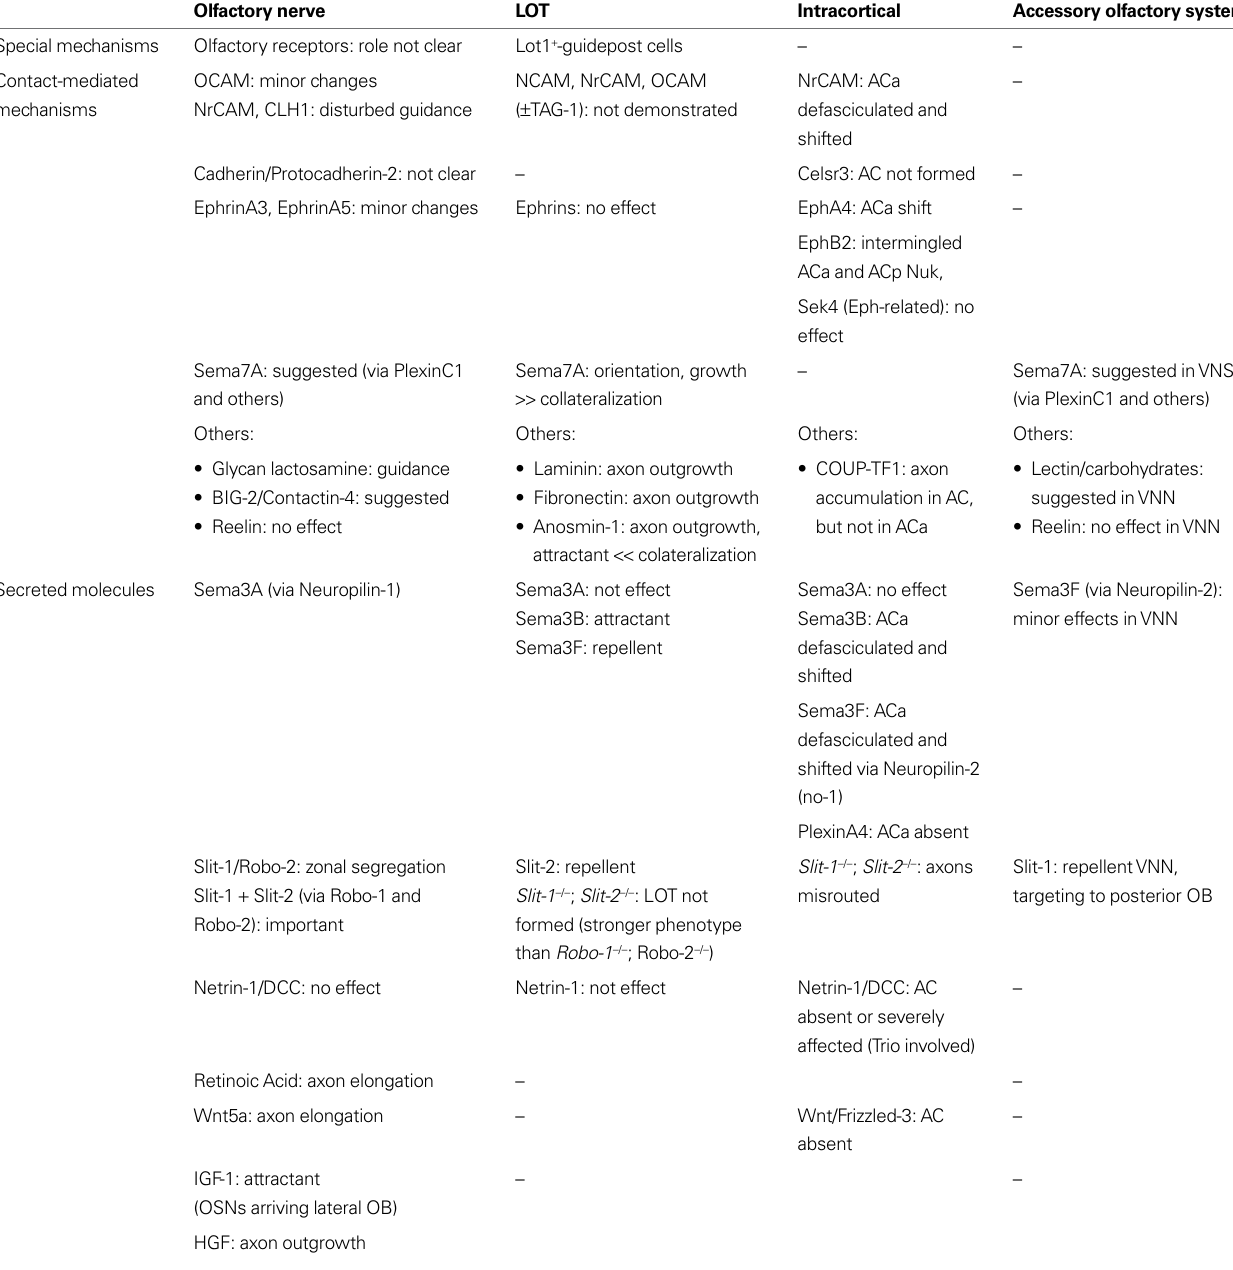
Table 1 | Comparative effects of molecules in the formation of the olfactory nerve, the LOT and the intracortical connections of the olfactory